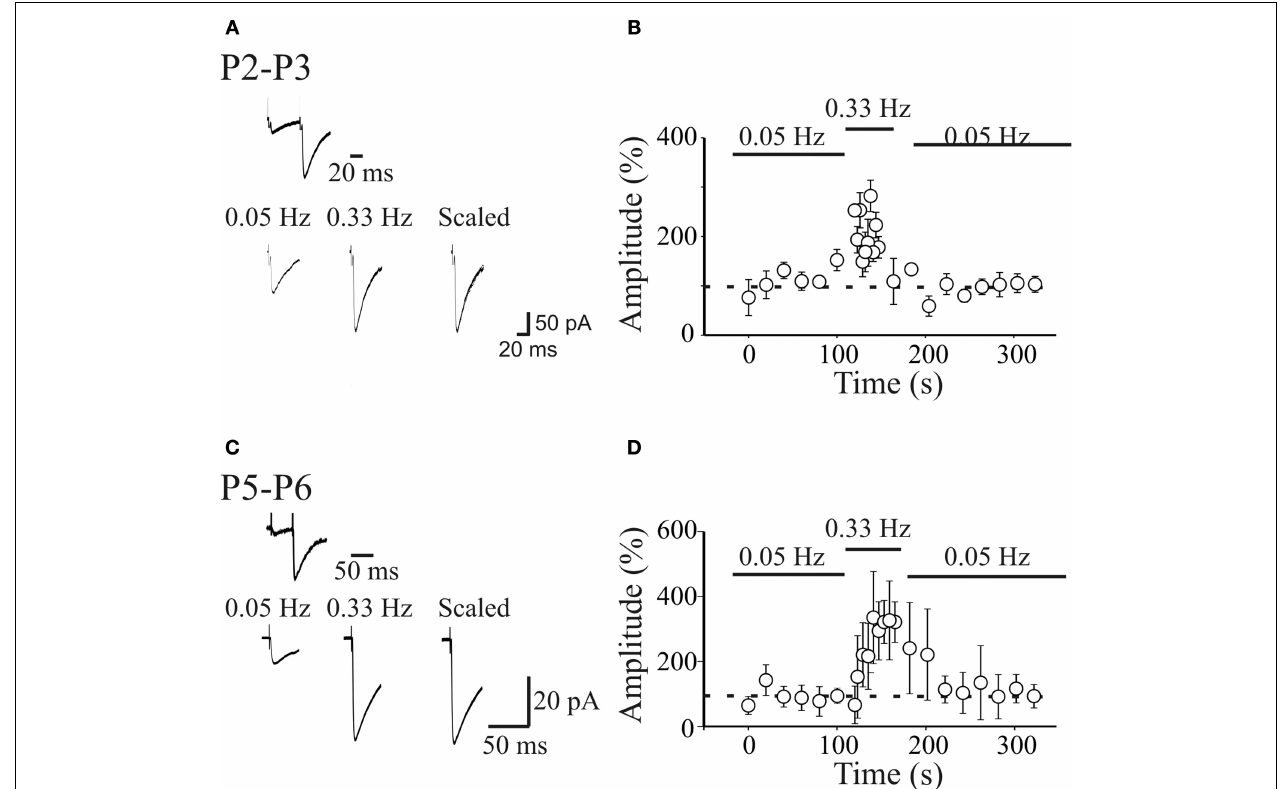
FIGURE 2 | Short-term frequency-dependent facilitation of MF-GPSCs. (A) Upper trace: MF-GPSCs exhibiting strong paired-pulse facilitation in response to two stimuli (50 ms apart) delivered to the granule cells in the dentate gyrus (P3). Lower traces represent averaged responses (including failures) obtained at 0.05 and 0.33 Hz from the same neuron. (B) The mean